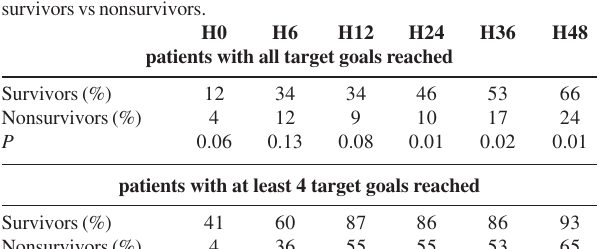
Table 4 - Proportion of patients reaching target goal value at each time point: survivors vs nonsurvivors. H0 H6